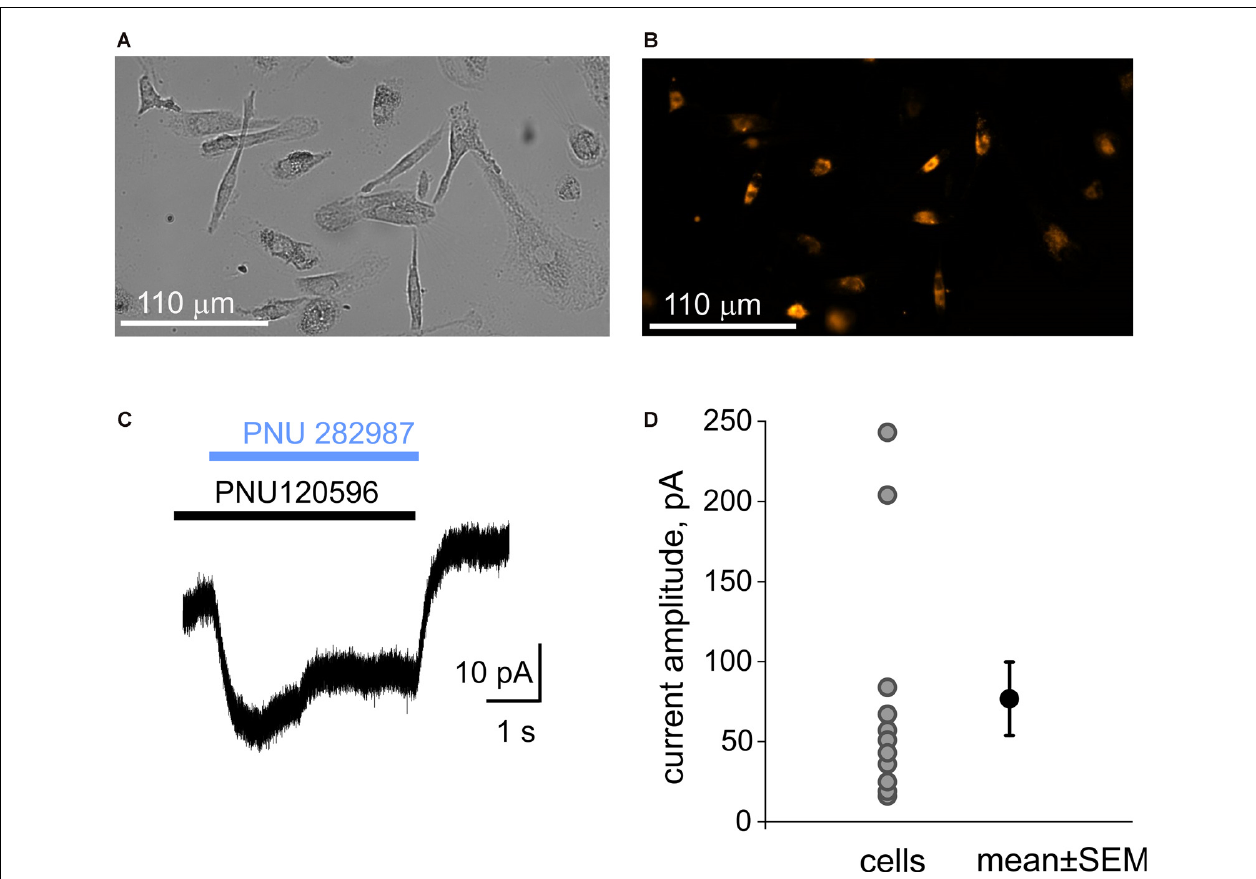
FIGURE 3 | Immunolabeling of α 7 receptors and patch-clamp recording of α 7 receptors mediated currents from macrophages (MDM cells). (A) A transparent light image of monocyte-derived macrophage (MDM) cells. (B) Detection of α 7 receptors with fluorescently labeled α -bungarotoxin. (C) Representative example of the membrane current activated by 1 µ M PNU 282987 together with 10 µ M PNU 120596 on MDM cells. Black and blue rectangles represent application of PNU120596 and PNU282987, respectively. (D) Plot showing amplitudes of responses in individual MDM cells (77 ± 23 pA, n =